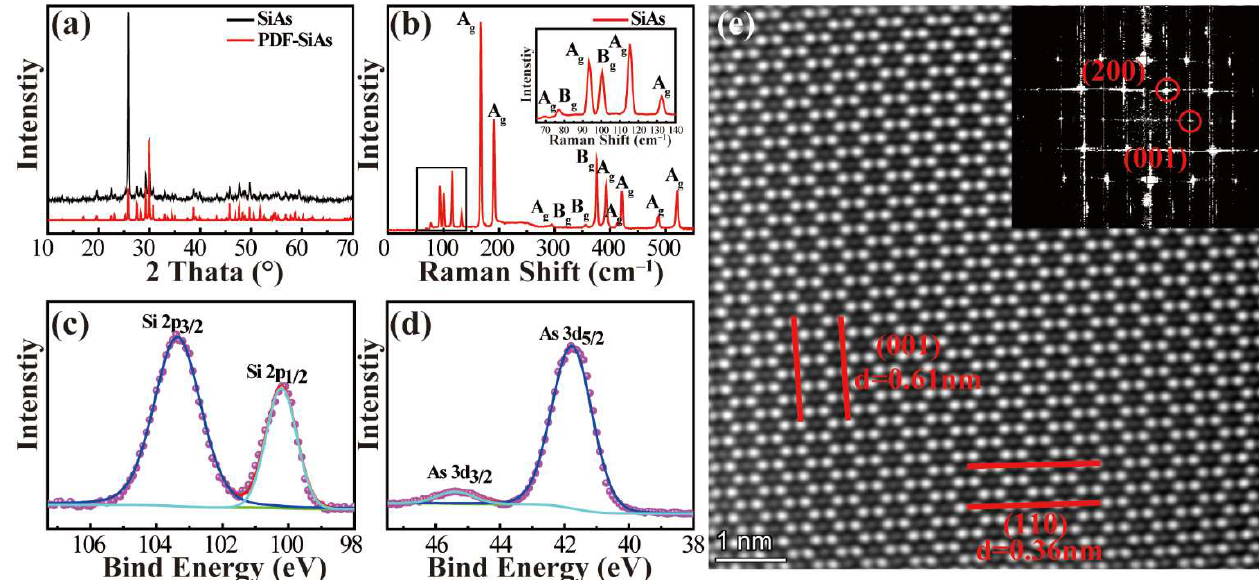
Figure 2. ( a ) XRD pattern of SiAs crystal powder. Take the monoclinic SiAs crystal PDF card with C2/m, a = 15.949 Å, b = 3.668 Å, c = 9.529 Å, β = 106° as a reference. ( b ) Raman spectrum of SiAs Crystals. Inset: Amplified spectrum in the range of 65 cm –1 ~140 cm –1 . ( c , d ) XPS spectra of SiAs powder after grinding. Through XPS spectroscopy, we did not find the characteristic peaks of other impurity atoms, proving that the quality of the grown SiAs crystals is good. ( e ) A typical STEM image of a SiAs crystal supported on an ultra-thin carbon film.